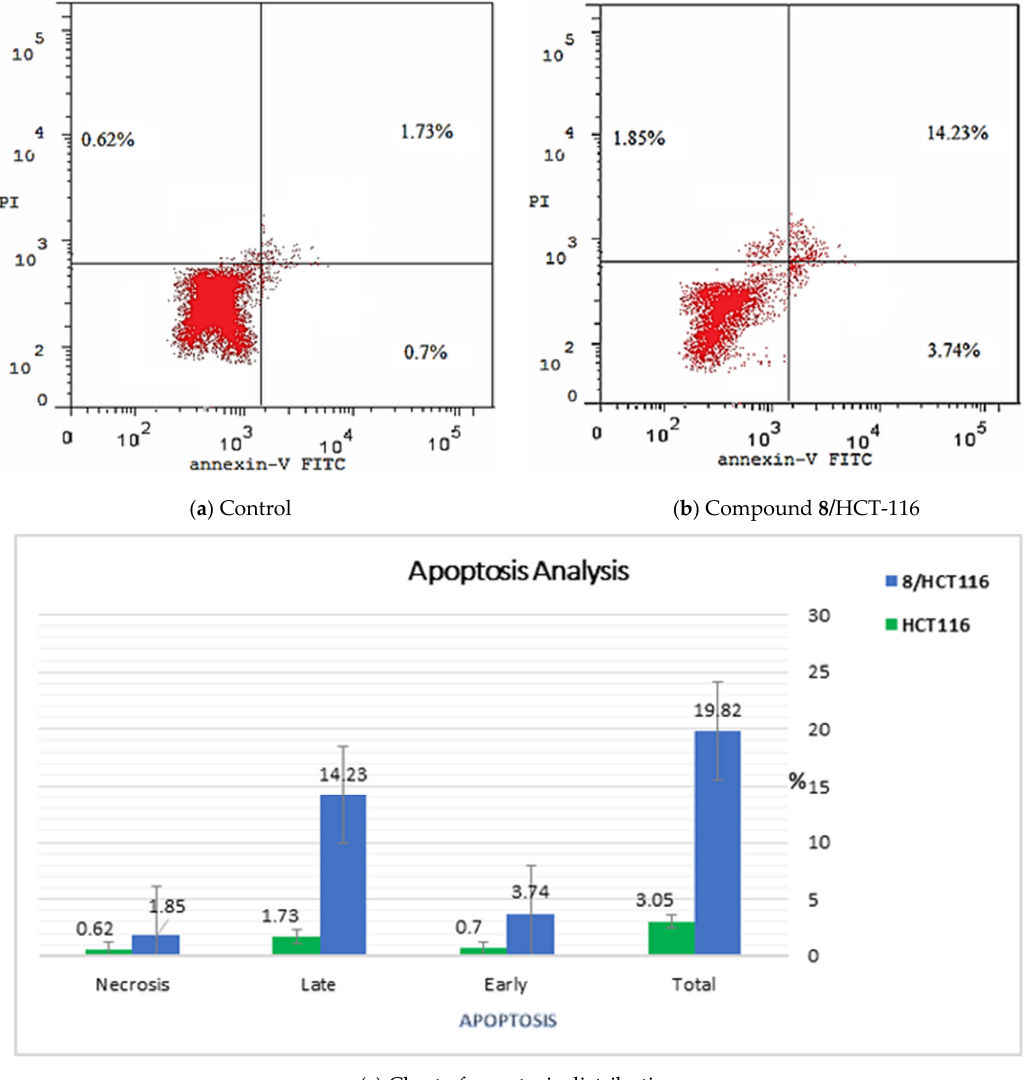
Figure 4. Flow cytometric analysis of apoptosis in HCT-116 cells after exposure to compound 8 (5.4 µM) after treatment for 24 h.